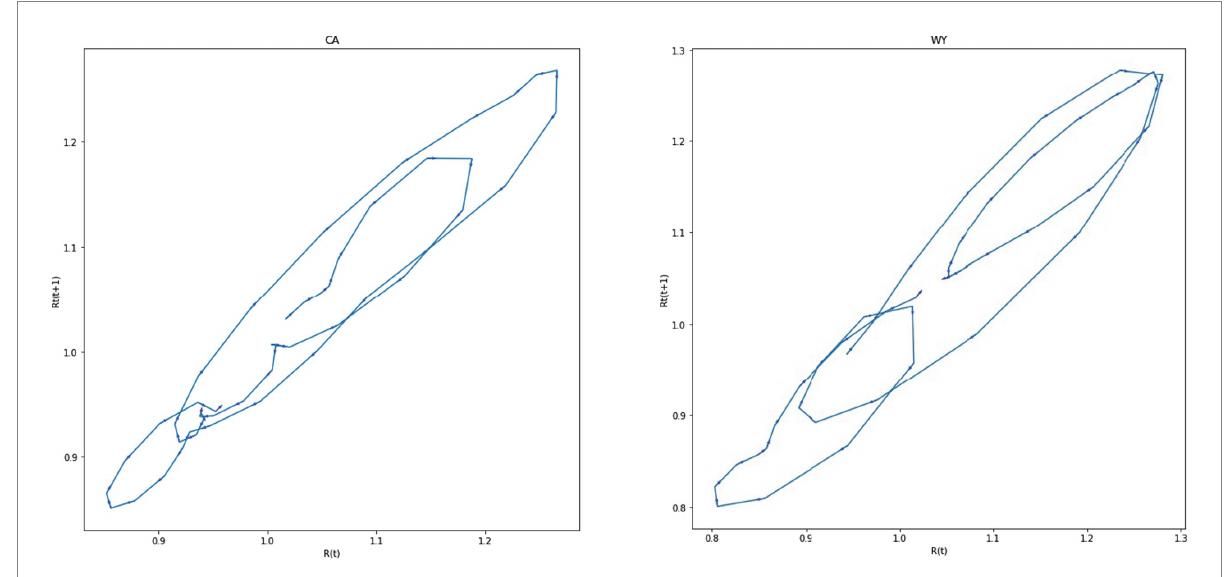
FIGURE 8 The oscillation of the effective reproduction number in two United States states.